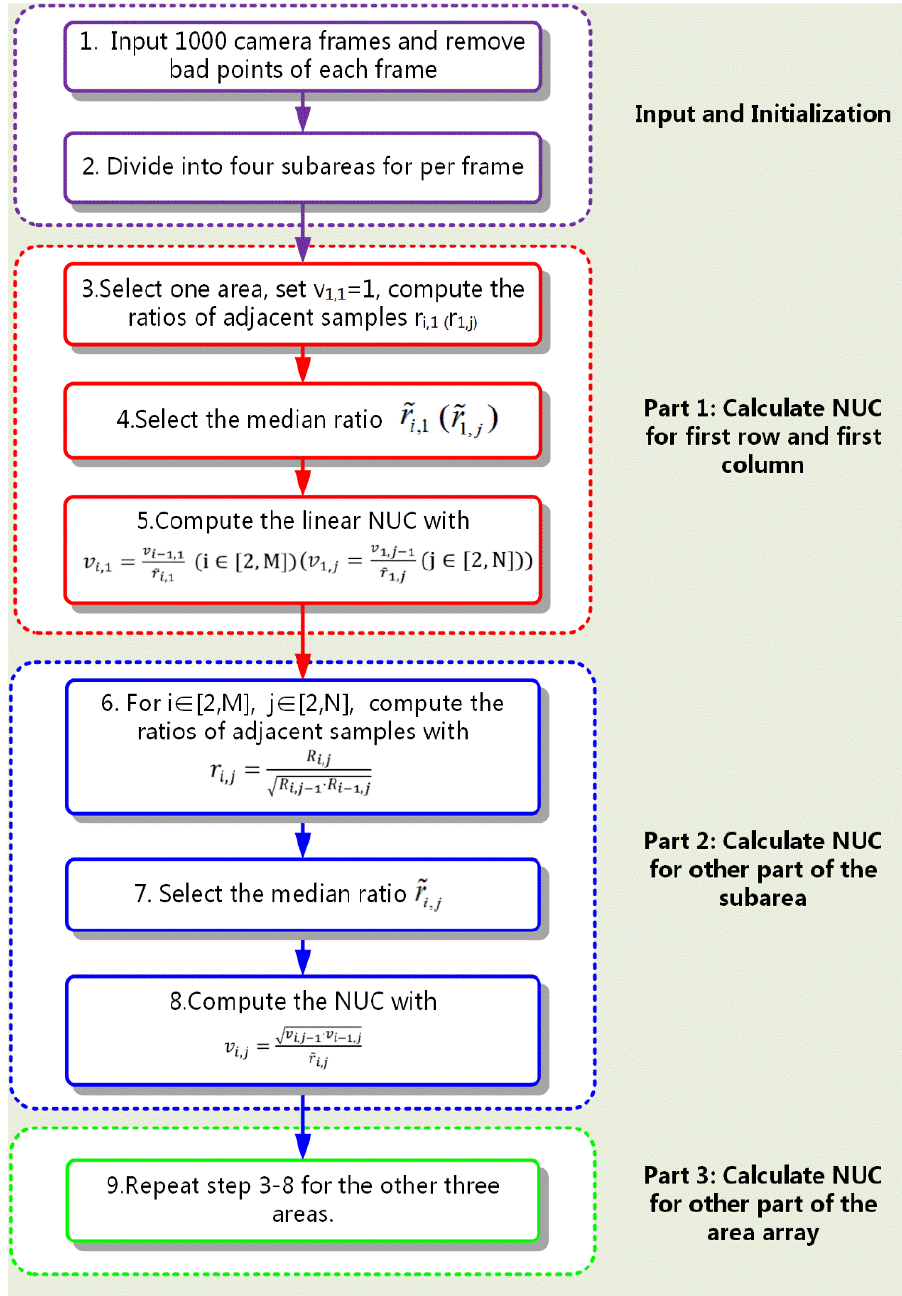
Figure 3. Procedure of MRSBNUC method.